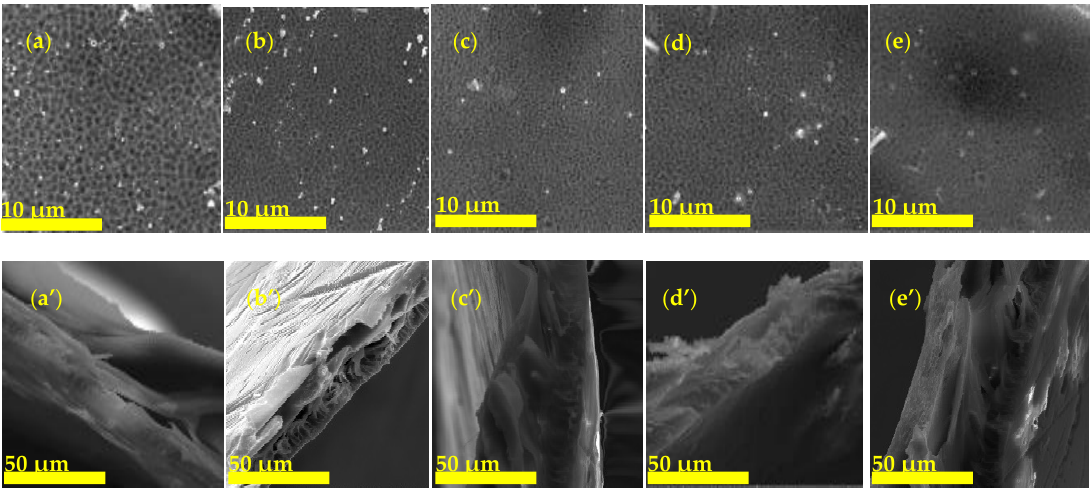
Figure 5. SEM surface and cross‐sectional’ micrographs of ( a ) PES and ( b ‐ e ) ZSM‐22/PES membrane